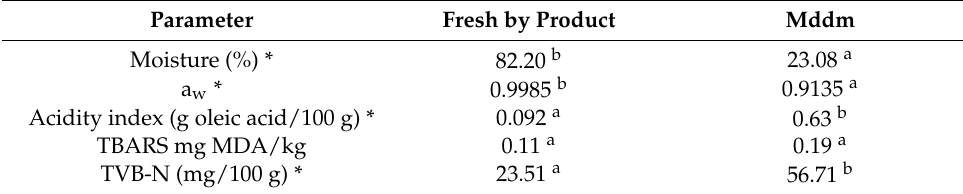
Table 2. Physicochemical properties of fresh by-product and MDDM. Parameter Fresh by Product Mddm Moisture (%) * 82.20 b 23.08 a a w * 0.9985 b 0.9135 a Acidity index (g oleic acid/100 g) * 0.092 a 0.63 b TBARS mg MDA/kg 0.11 a 0.19 a TVB-N (mg/100 g) * 23.51 a 56.71